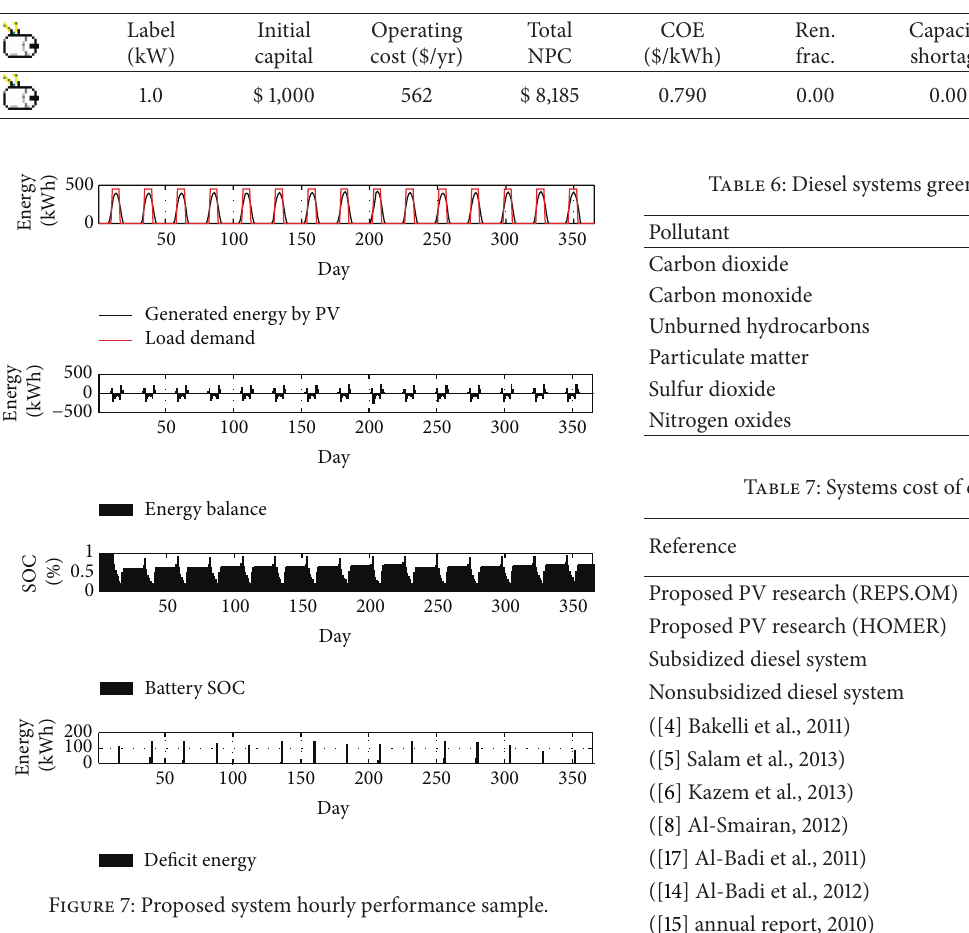
Table 5: Diesel system results for 0.38 USD/Litre.